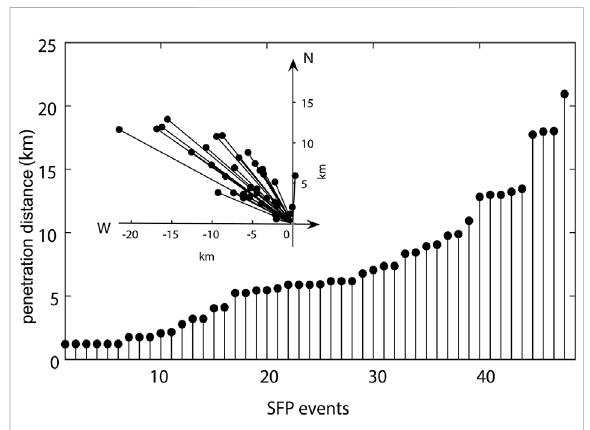
FIGURE 2 Penetration directions and distances (km) of 48 SFP events usedinthisstudy.Thecoordinator ’ soriginintheinsetindicatesthe SFP-centerlocationwhenseafog fi rstappearedonland.Theblack dot indicates the SFP-center location when SFP covered most inland stations during an SFP event. The SFP-center location is de fi ned as the mean location of fog-affected inland AWSs. The distance from the coordinator ’ s origin to the dot indicates the penetration distance of the SFP event (main fi